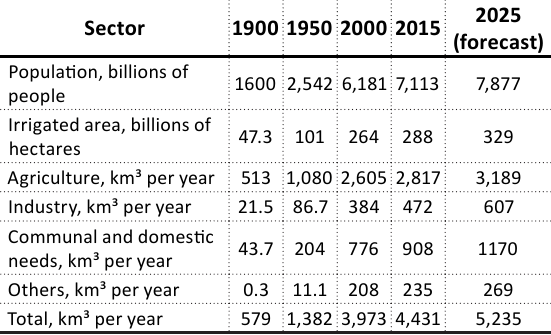
Table 1. The dynamics of water use in the world by